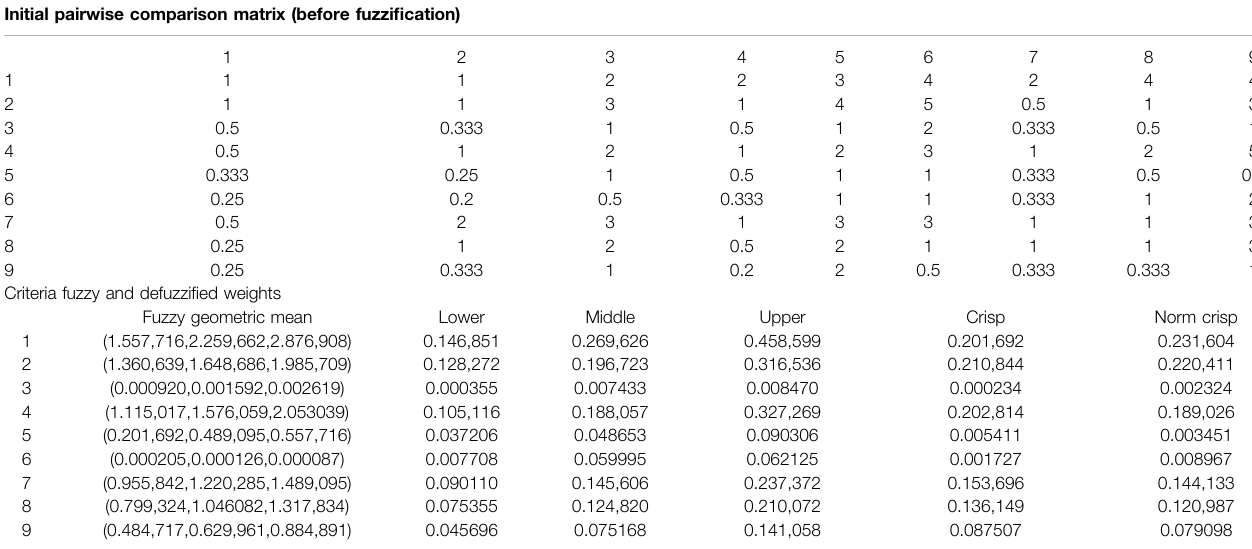
TABLE 5 | Fuzzy AHP results per criteria category – Category Economics. Initial pairwise comparison matrix (before fuzzi fi cation)